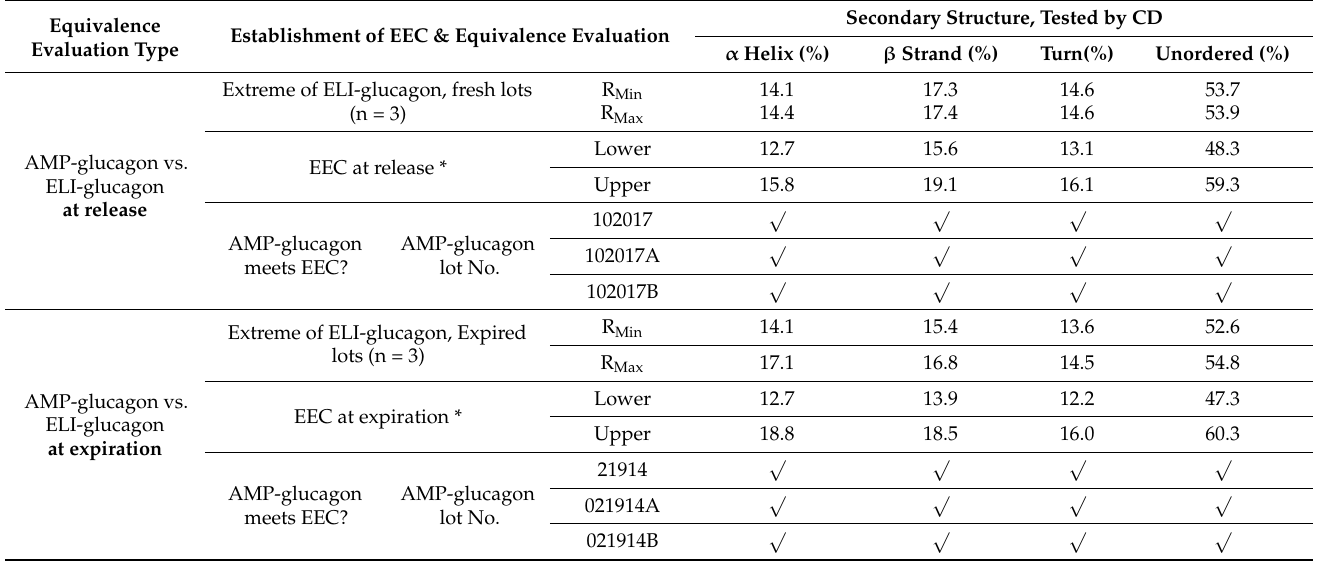
Table 2. Equivalence Evaluation for Secondary Structure with CD Method for AMP-Glucagon vs. ELI-Glucagon.